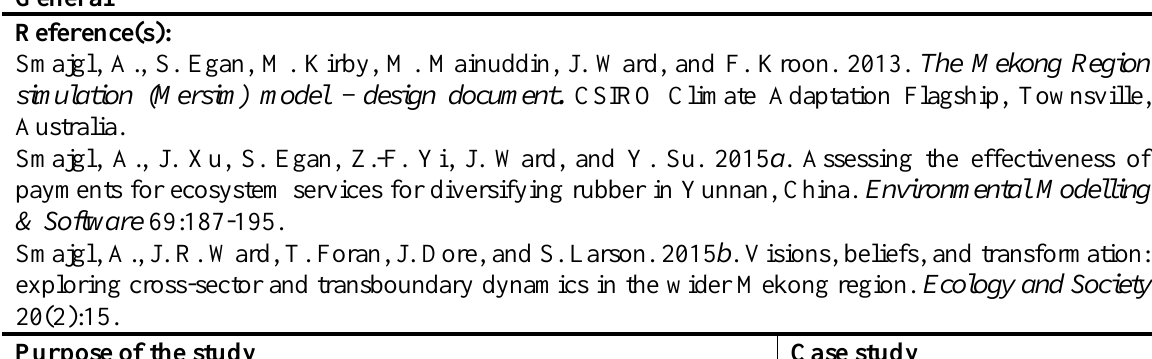
Table A1.12 Standardized protocol for the ABM described by Smajgl et al. (2013; 2015a;